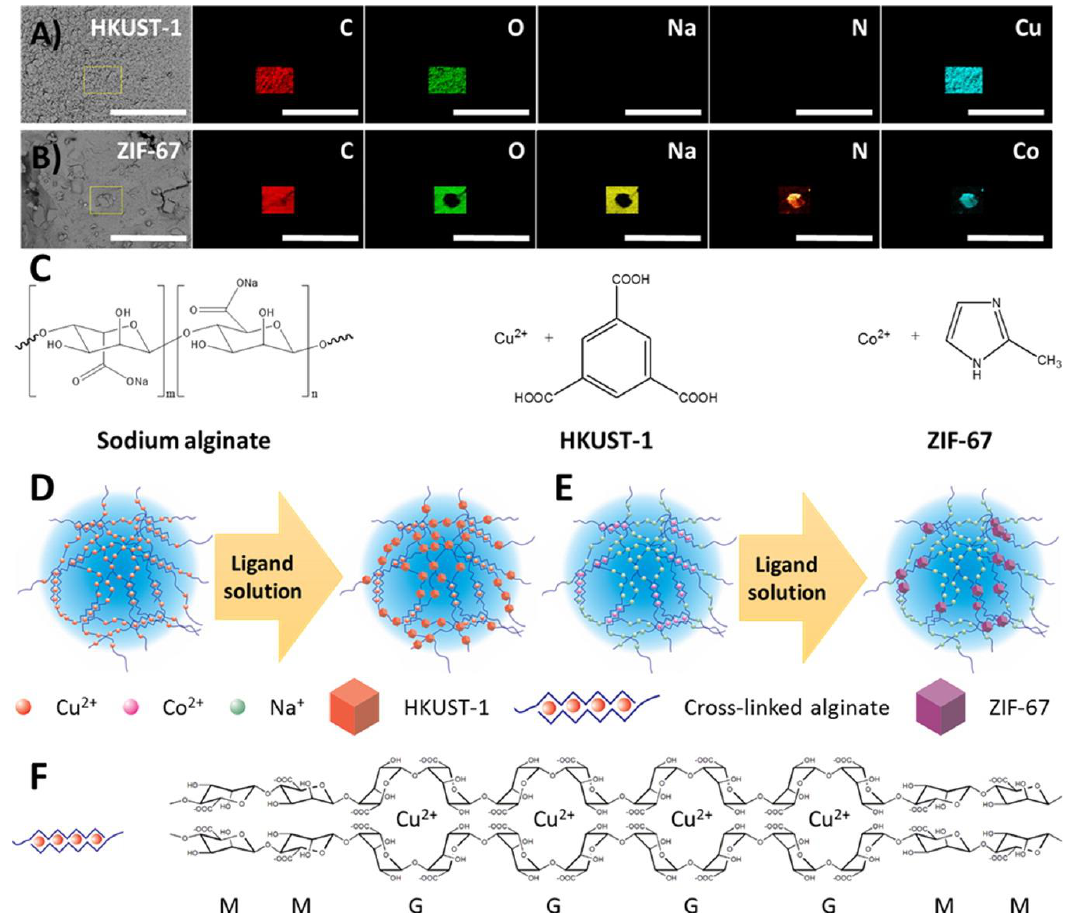
Figure 9. Cross-section backscattered electron images of ( A ) HKUST-1– and ( B ) ZIF-67–alginate composites and their corresponding EDX elemental maps (scale bar of 60 μm). ( C ) Chemical composition of sodium alginate, HKUST-1, and ZIF-67. Schematic of the formation of ( D ) the HKUST-1–alginate composite, ( E ) the ZIF-67–alginate composite, and ( F ) the “egg-box” model of metal ion cross-linked alginate [159]. Reprinted with permission from Ref. [159]. Copyright American Chemical Society,